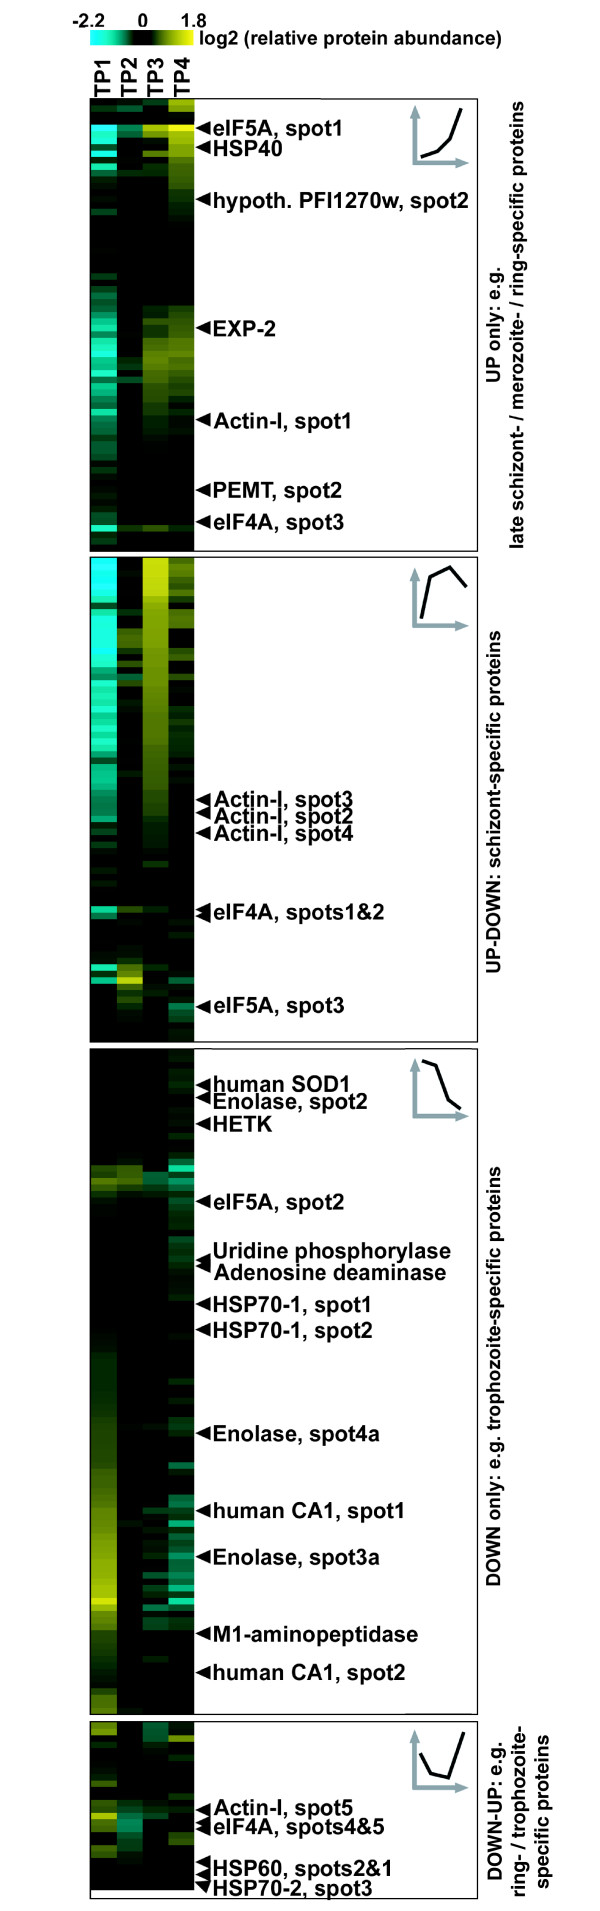
Statistics of changes in relative protein abundance. (a) Cumulative histogram of maximum fold change in relative abundance for proteins/isoforms that exhibit significant change (analysis of variance [ANOVA] P < 0.01) throughout the four schizont-stage time point (TP) samples. (b) the pie chart on the left illustrates how the 623 differential gel electrophoresis (DIGE) protein expression profiles are distributed among four categories defined by the statistical measures of variation (ANOVA), experimental reproducibility (median relative standard deviation [RelStDev]), and the maximum fold change (MFC) of relative protein abundance. The partial pie chart on the right provides an additional classification relating to the direction of abundance change, with the icons giving a generic illustration of each category.